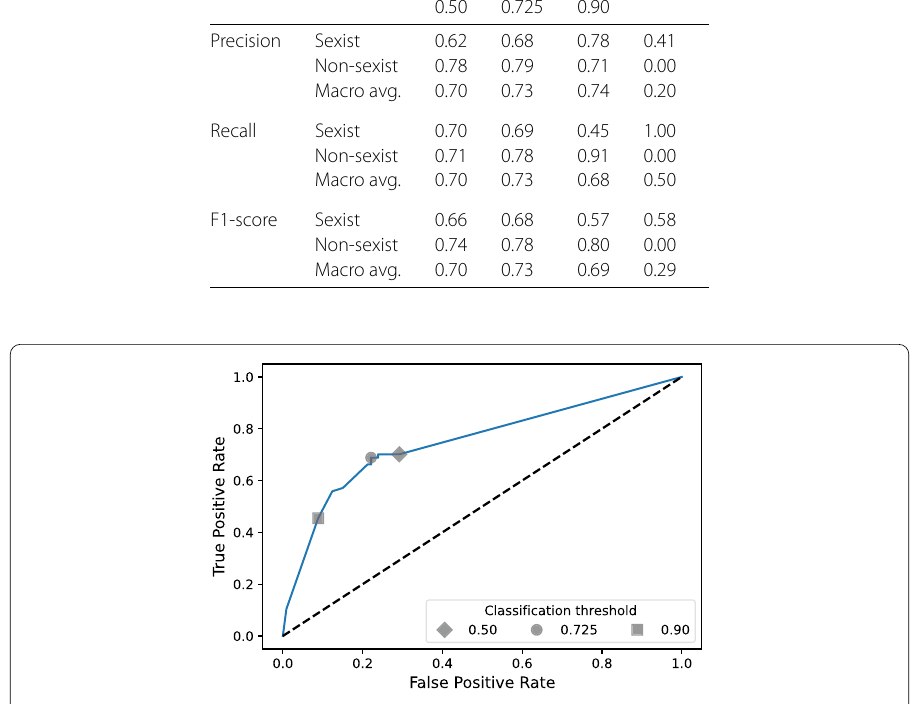
Figure 6 ROC curve of the sexism classifier for N B = 1. Markers indicate the points corresponding to the three classification thresholds discussed